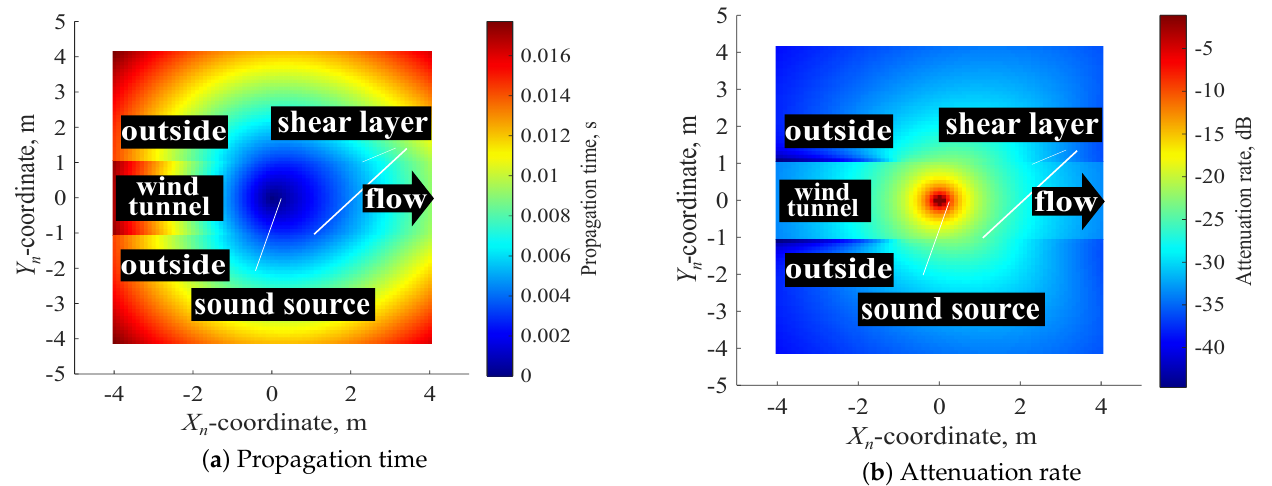
Figure 4. The distributions of propagation time and attenuation rate in the X n − Y n plane ( Z n =